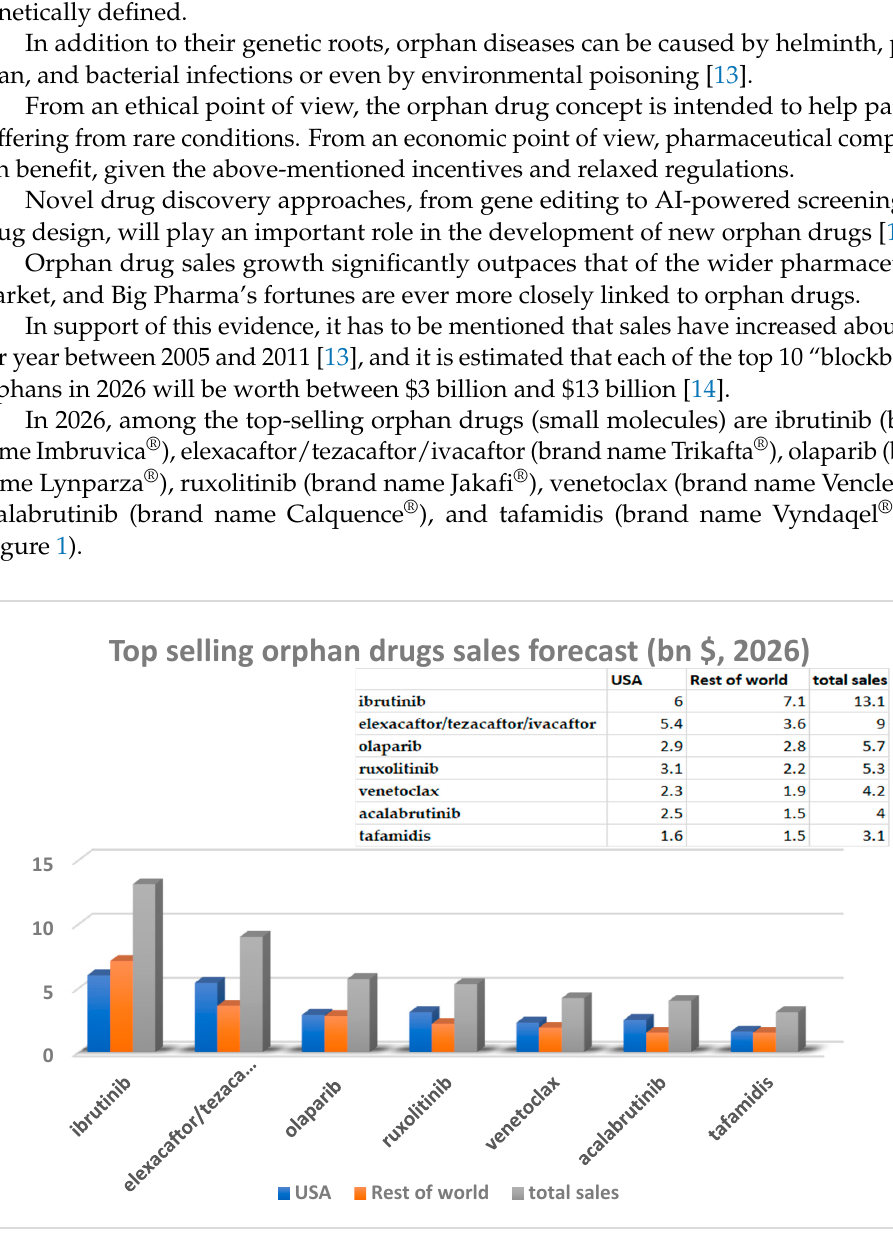
Figure 1. Top selling orphan drugs sales (bn $, forecasted sales for 2026) [14].